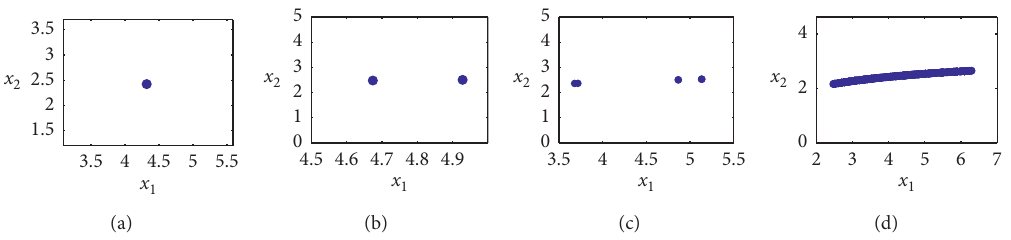
Figure 4: Periodic 1, 2, and 4 and chaotic Poincare section of 3D jerk system (1) with different a . (a) a � 3:31, b � 1, c � 4. (b) a � 3 :34, b � 1,